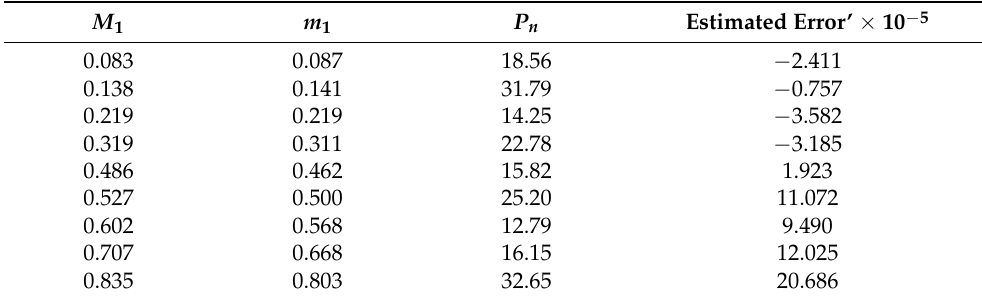
Table 7. The input data for medium conversion and r 1 = 0.72 and r 2 = 0.92 (MC2).